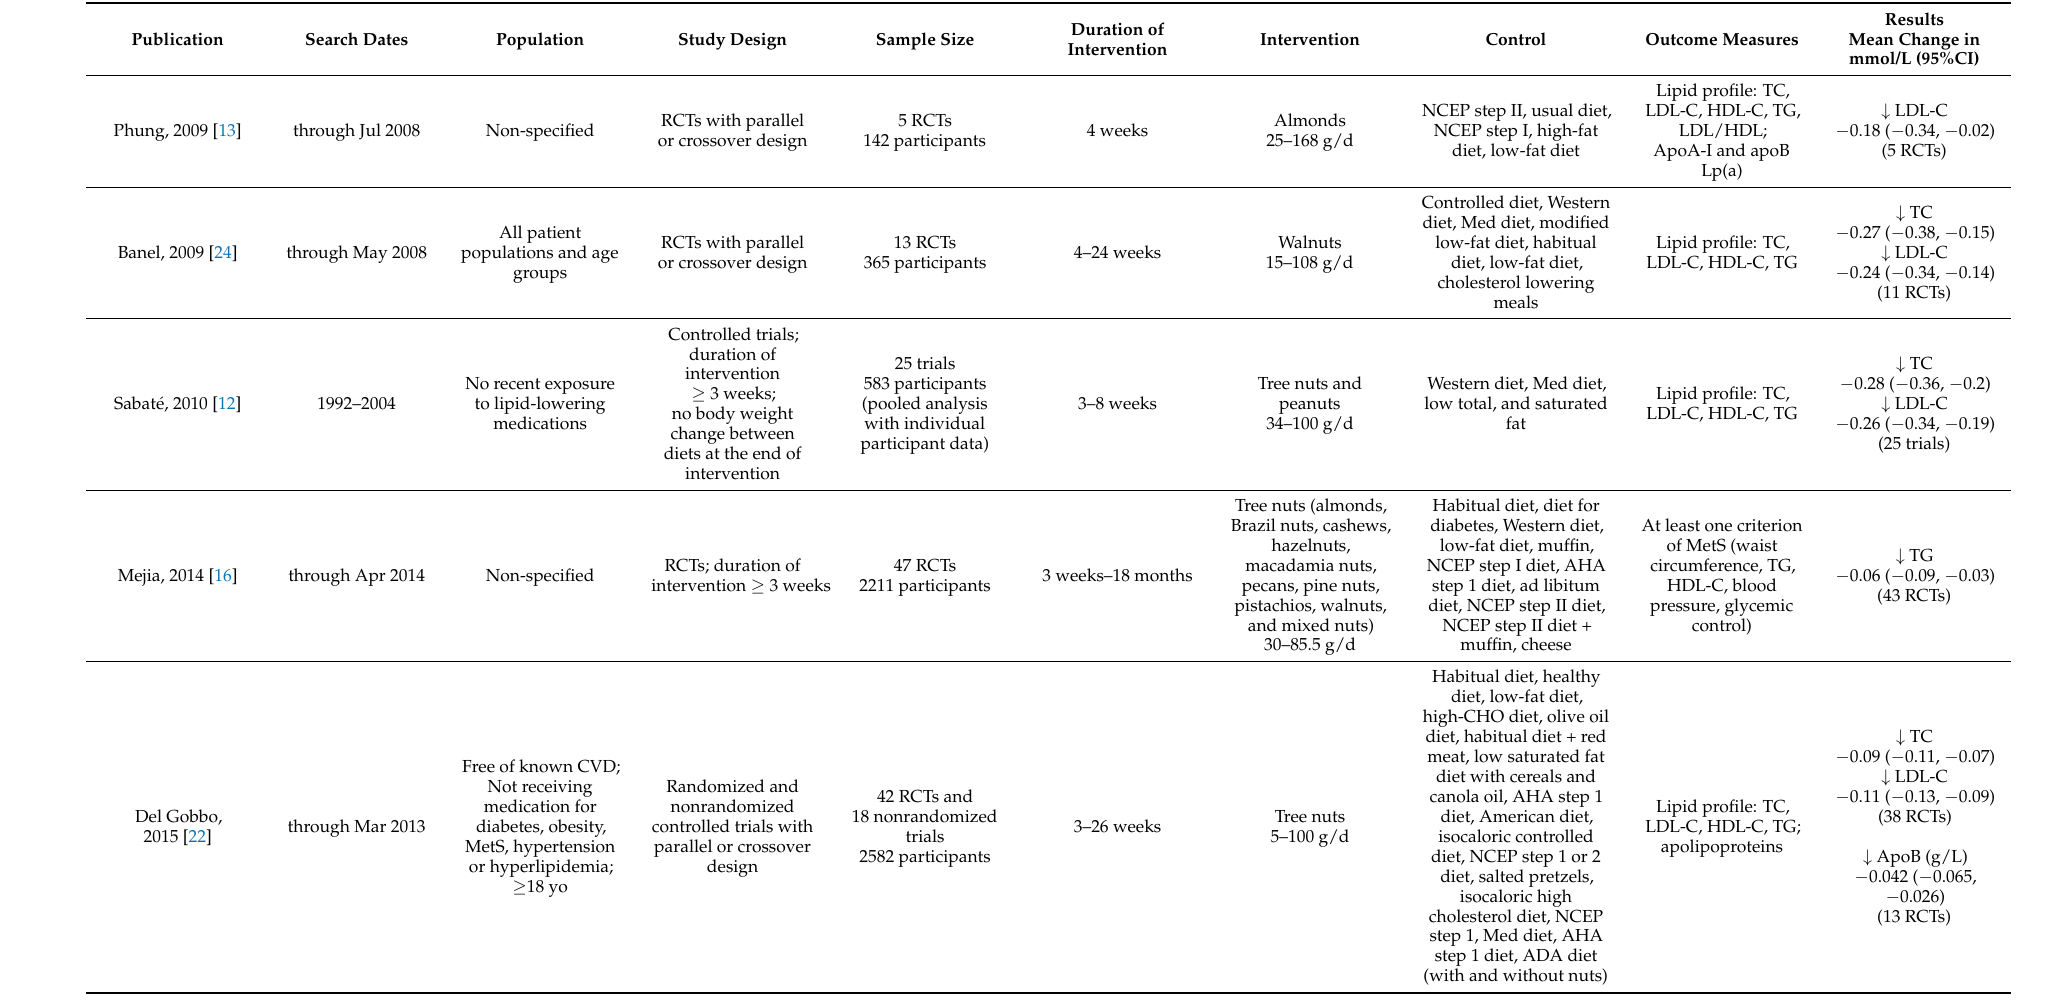
Table 1. Summary of meta-analyses on the effect of nuts and peanuts on lipid and lipoprotein